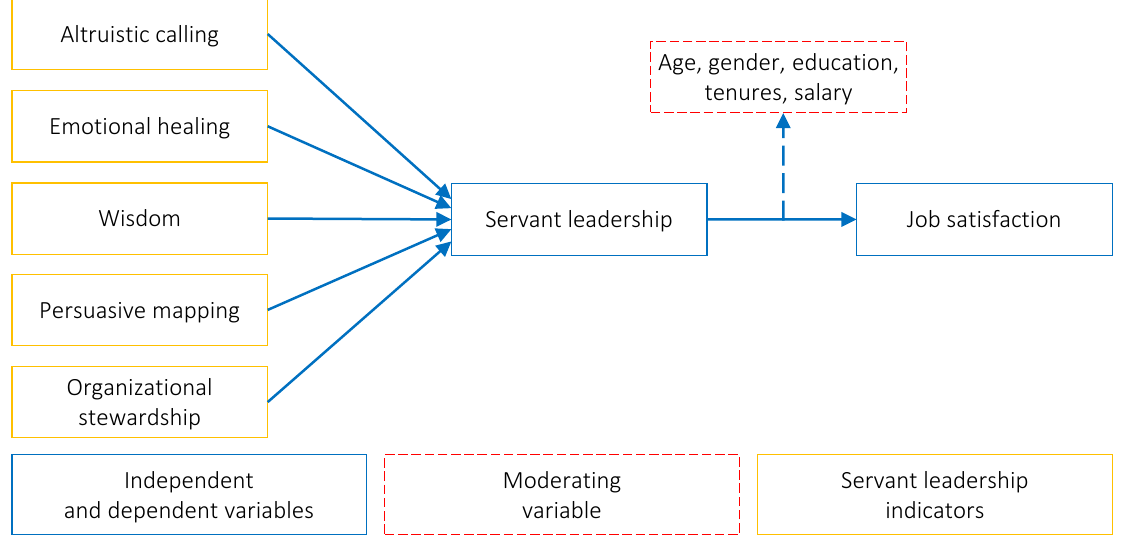
Figure 1. Research conceptual